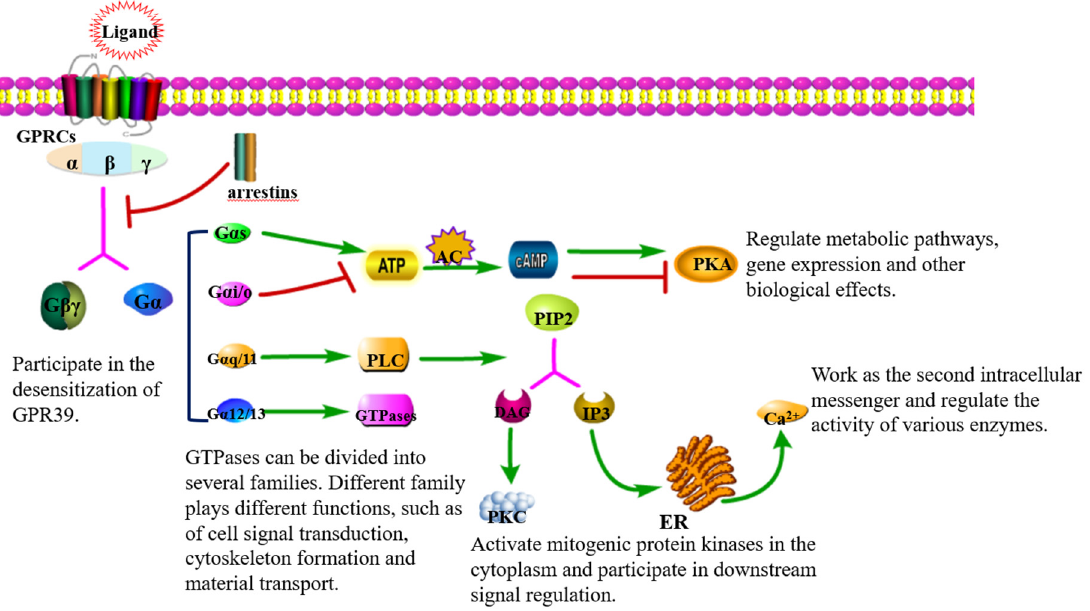
Figure 1. Signal transduction of GPCRs [17,18,25,26,29]. Upon stimulation, GPCRs not only couple to regulatory proteins, such as arrestins, but also trigger the activation of different G protein subtypes including G α s, G α i/o, G α q/11, and G α 12/13, which participate in the signal transduction pathway and mediate unique physiological or pathological functions. An arrow between two elements means that the side being pointed at is activated. Conversely, the symbol ( ├ ) represents an inhibit- ing effect. Abbreviation. ATP: adenosine triphosphate, AC: adenylate cyclase, cAMP: cyclic adeno- sine monophosphate, PKA: protein kinase A, PLC: phospholipase C, PIP2: phosphatidylinositol-tol- 4,5-bisphosphate, DAG: diacylglycerol, PKC: protein kinase C, IP3: 1,4,5-inositol triphosphate, ER: endoplasmic reticulum.